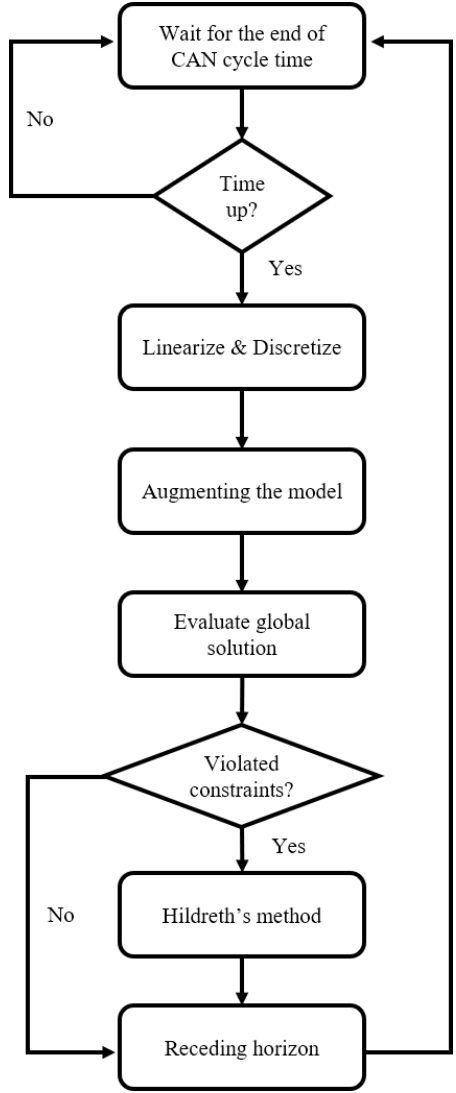
Figure 3. Adaptive MPC flow chart for model-based design approach.